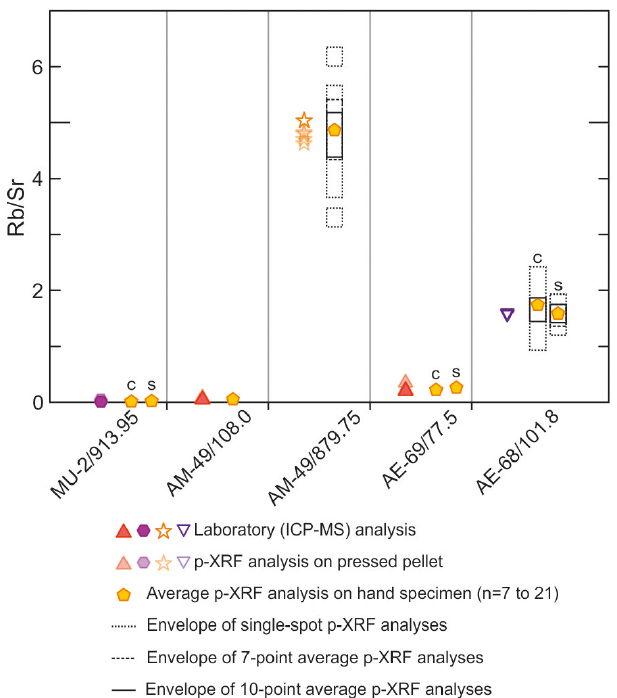
Figure 14. Comparison between Rb / Sr data obtained from labo- ratory (ICP-MS) and p-XRF whole rock geochemistry analyses of representative samples. c: cut core section; s: core surface.